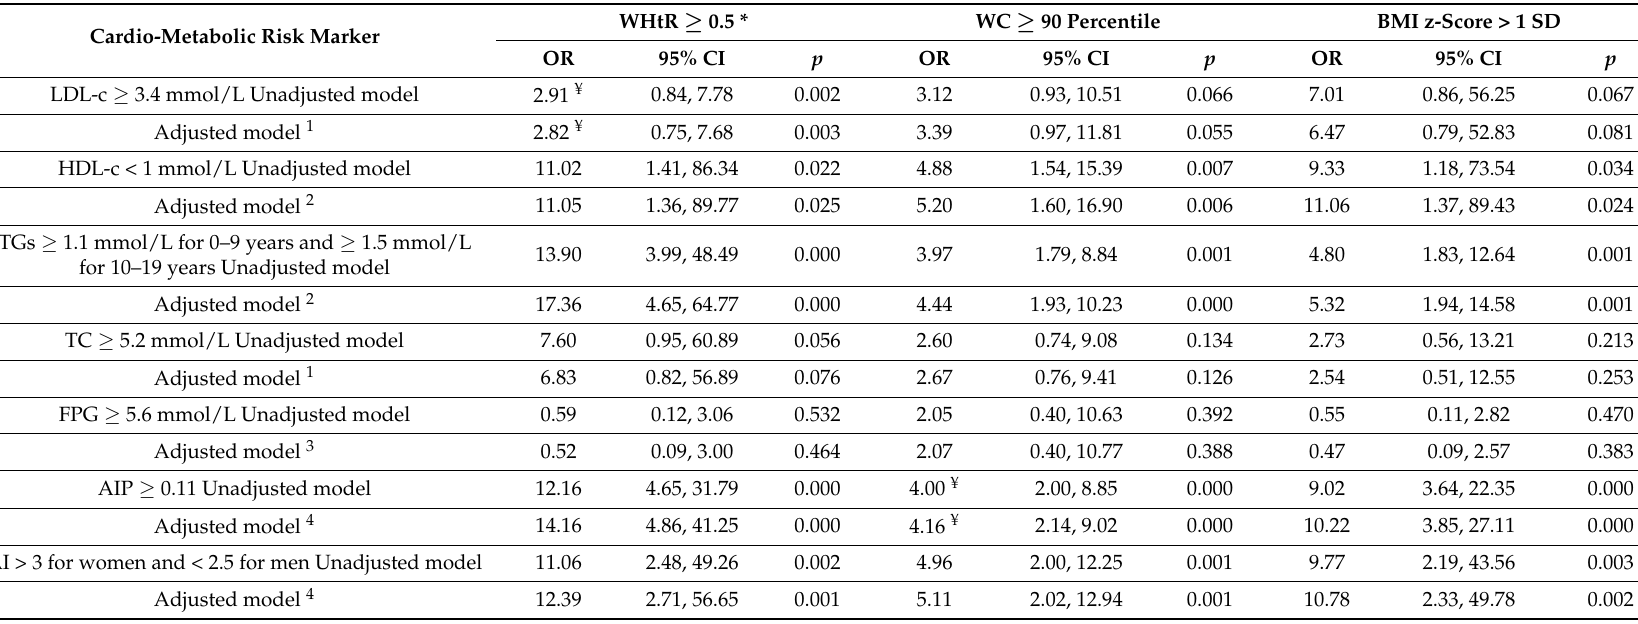
Table 5. Logistic regression analyses for the association of excess general (z-BMI > 1 SD) and abdominal (WC ≥ 90 percentile or WHtR ≥ 0.5) adiposity and cardio-metabolic risk